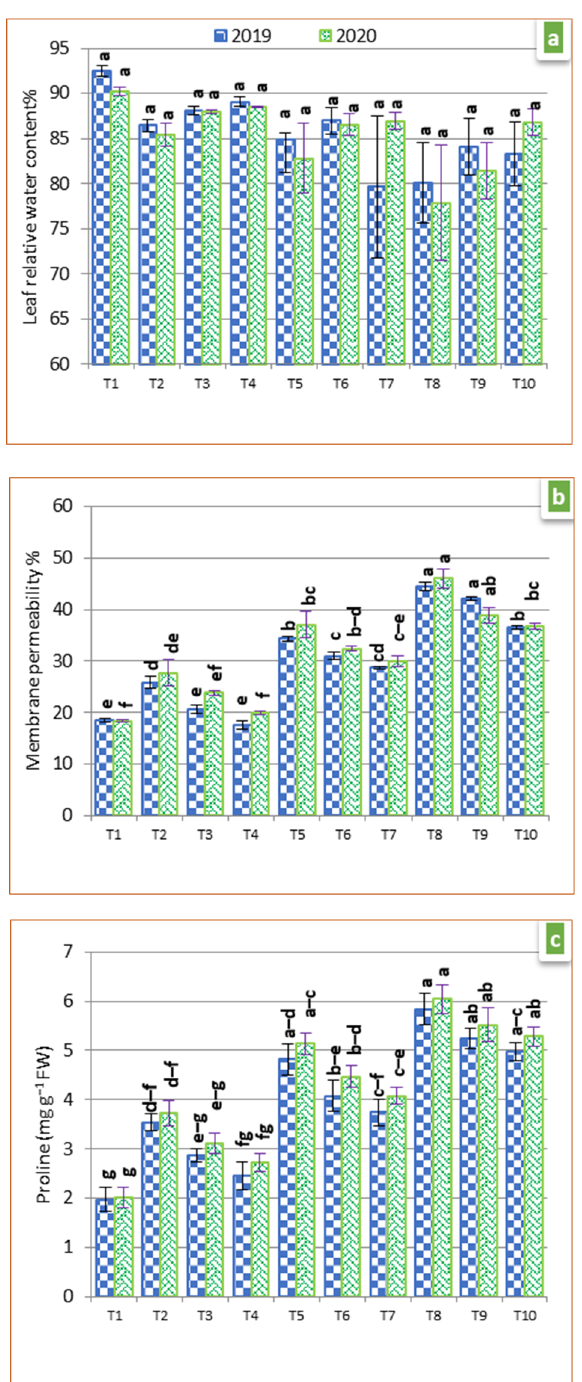
Figure 2. Leaf relative water content ( a ), membrane permeability percentage ( b ), and proline concentration ( c ) of grapevine seedling as affected by salinity (NaCl) and brassinolide (BL) during both growing seasons. Data represent the average of five replicates ± standard error. Different letters in each column indicate significant ( p ≤ 0.05) differences at p ≤ 0.05 according to Tukey’s HSD range at p ≤ 0.05. (T1, 0 NaCl without BL application; T2, 1000 mg L − 1 NaCl without BL application; T3,